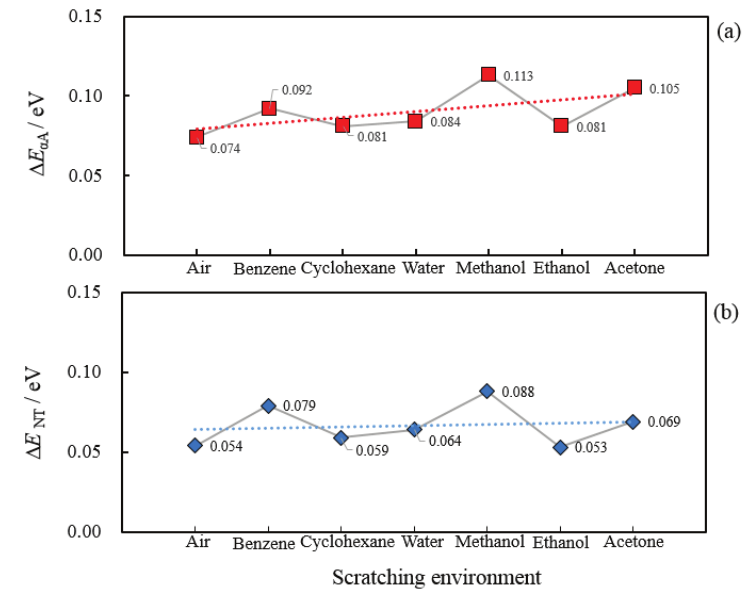
Figure 12. Plots of the activation energies, ∆ E α A ( a ) and ∆ E NT ( b ), obtained from the wavelength scan against the scratching environments.